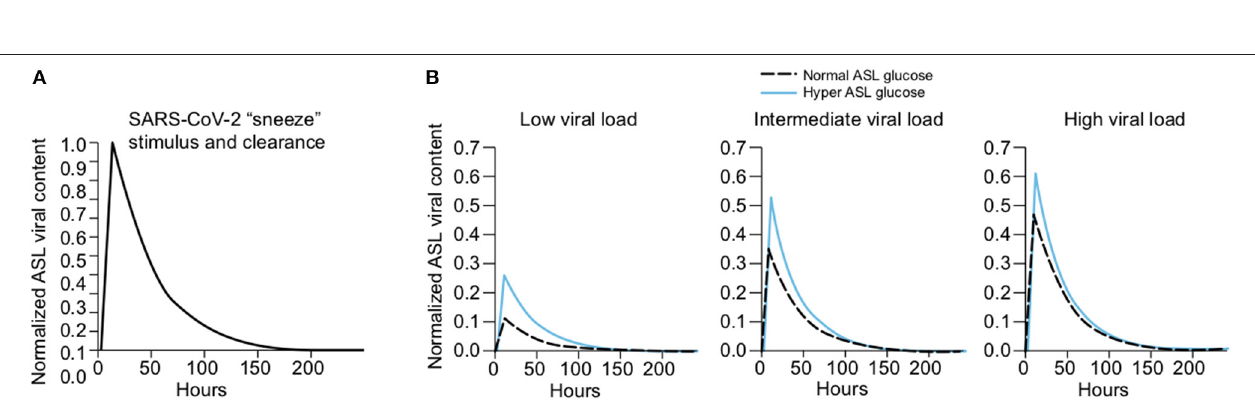
FIGURE 22 | Simplified computational model of SARS-CoV-2 endocytosis as a function of glucose concentration in ASL and viral load at time of a sneeze stimulus. (A) A theoretical model of the time course of an arbitrary viral load of SARS-CoV-2 (sneeze stimulus) in the lung epithelial cells is represented. The rise time is a function of inhaling the virus and the decay time represents the clearance from the lung. (B) Simplified model of SARS-CoV-2 endocytosis in function of glucose concentration in the ASL (dashed line = control = 0.4mM, solid blue line = hyperglycemic = 1.2mM), after infection with a low, intermediate, or high viral load of SARS-CoV-2 at time of infection. The time course of the viral content in the ASL in each condition is